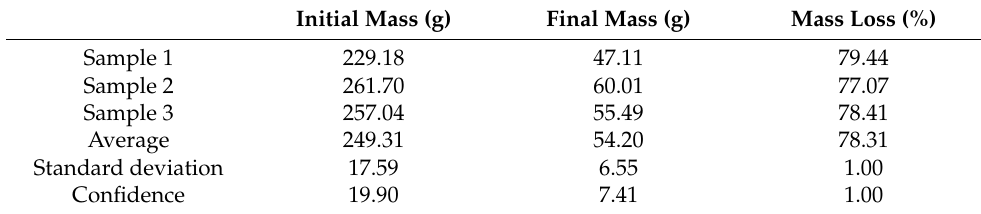
Table 6. Determination of mass loss of carbonized samples of vine pruning.